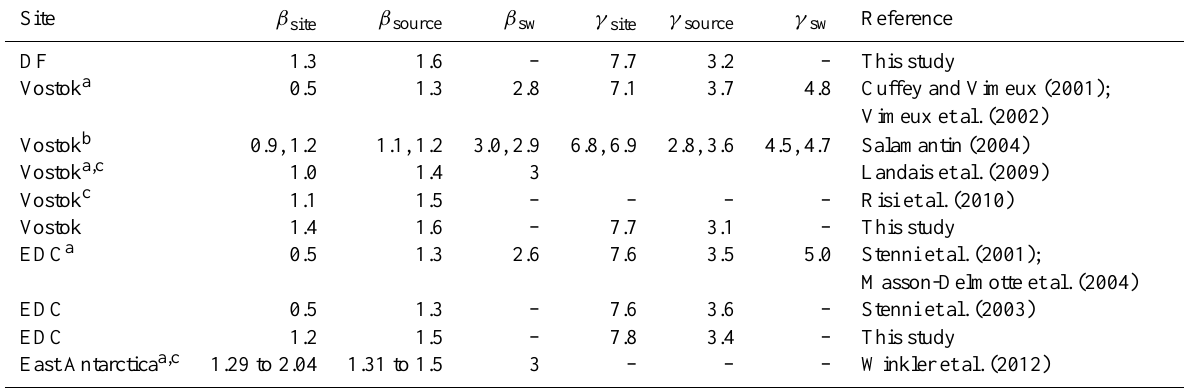
Table 1. Comparison of the tempearature inversion coefficients.